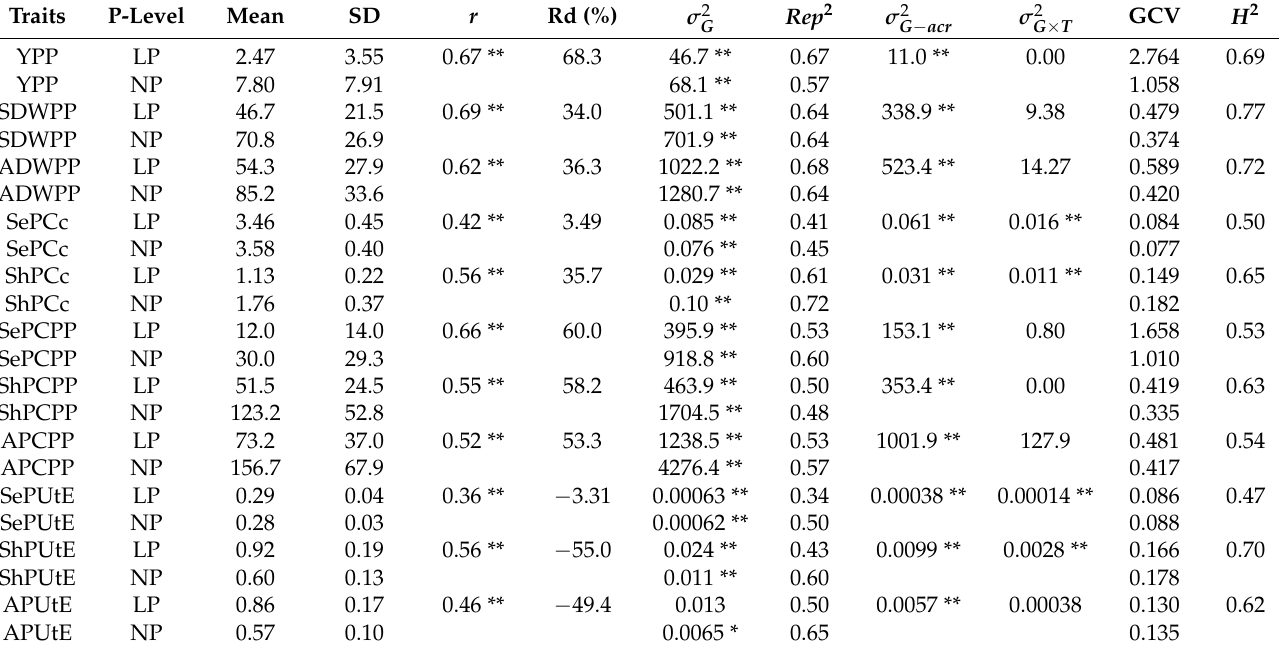
Table 1. Summary statistics of all traits under the two P